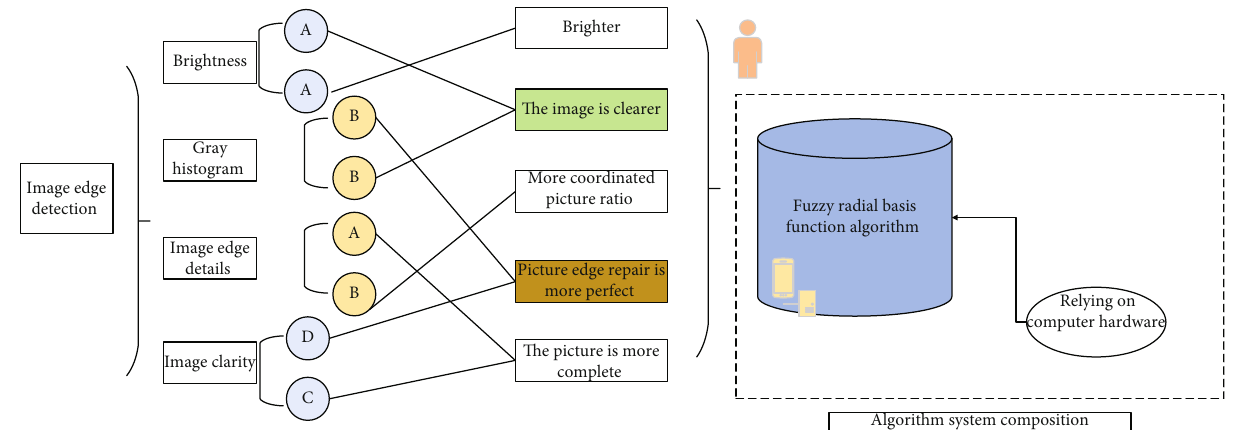
Figure 1: Block diagram of the fuzzy radial basis fuser structure.